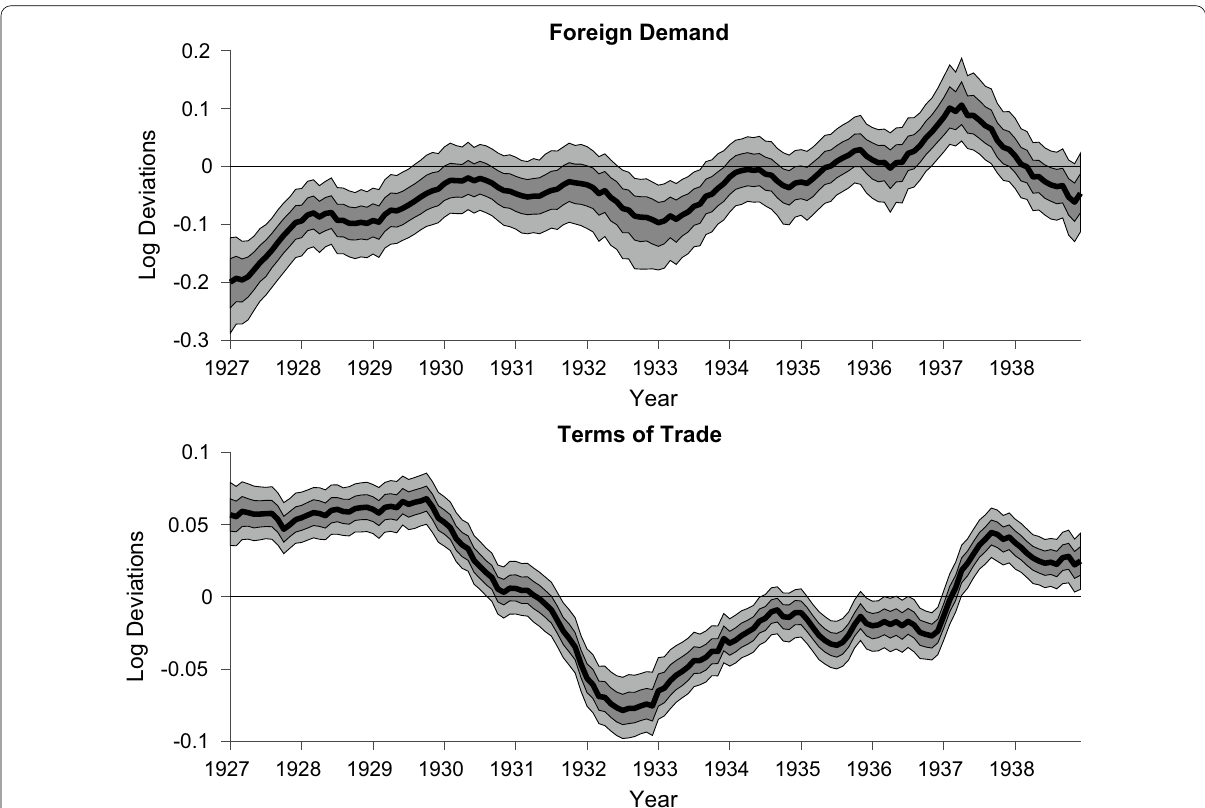
Fig. 4 Estimated Exogenous States. Results are based on 5000 draws from the posterior distribution. Light-gray shaded area represents 95 % probability bands, dark-gray shaded area represents 68 % probability bands, black line represents